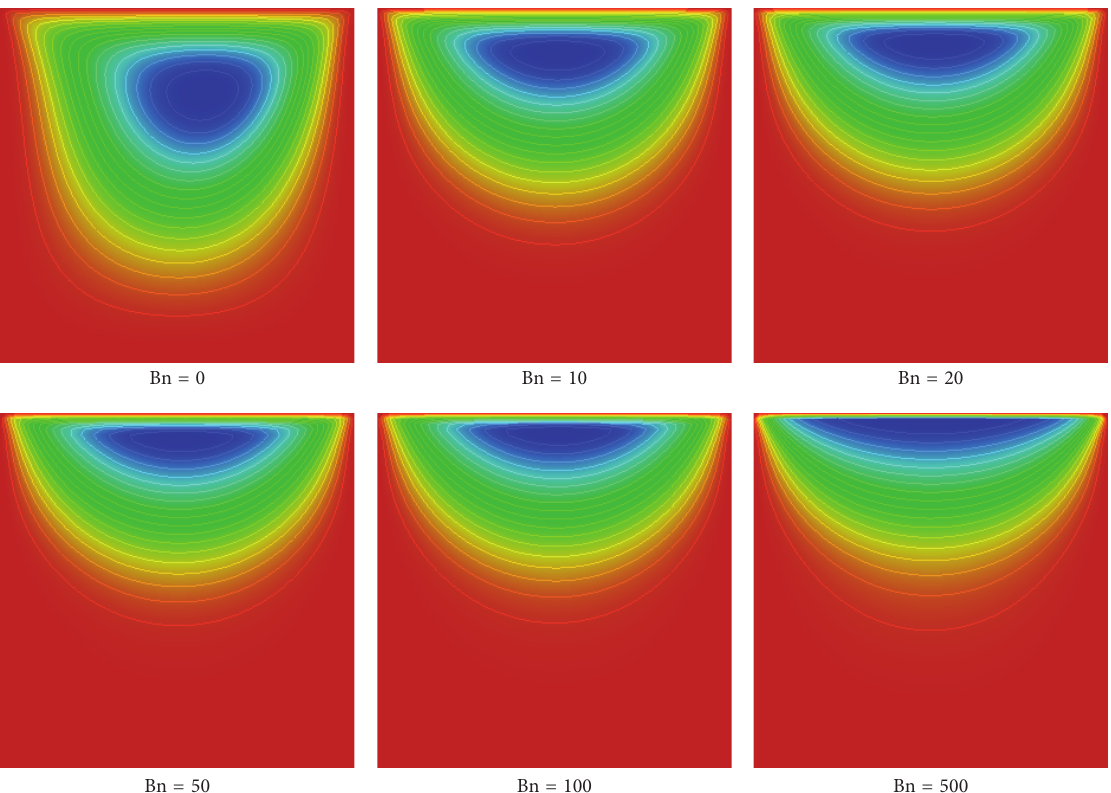
Figure 2: Stream function contours for different values of Bingham number